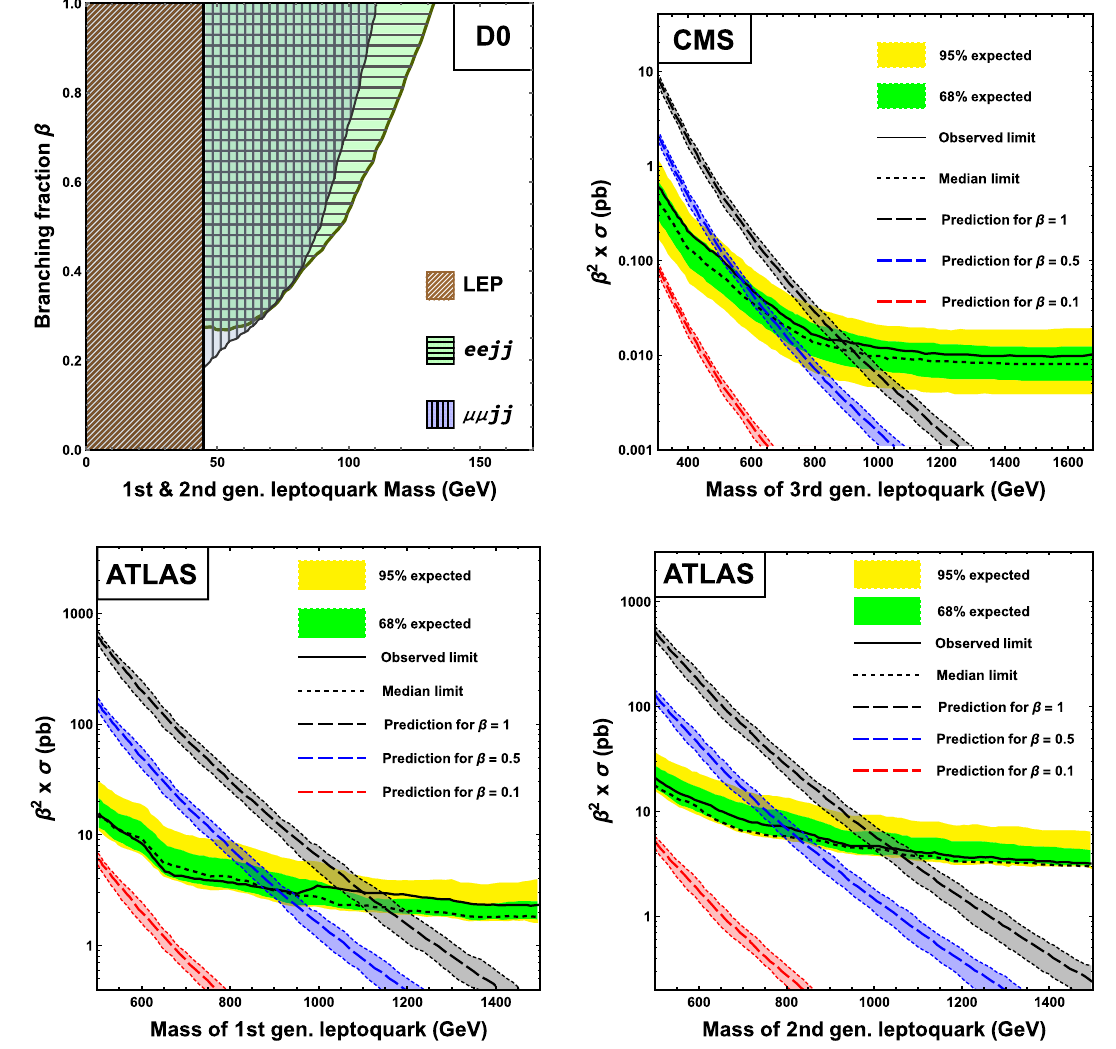
Fig. 3 Data from D0, CMS and ATLAS for the branching fraction against the allowed mass range for different generations of leptoquarks g − 2 of muon and electron, neutrino oscillation and